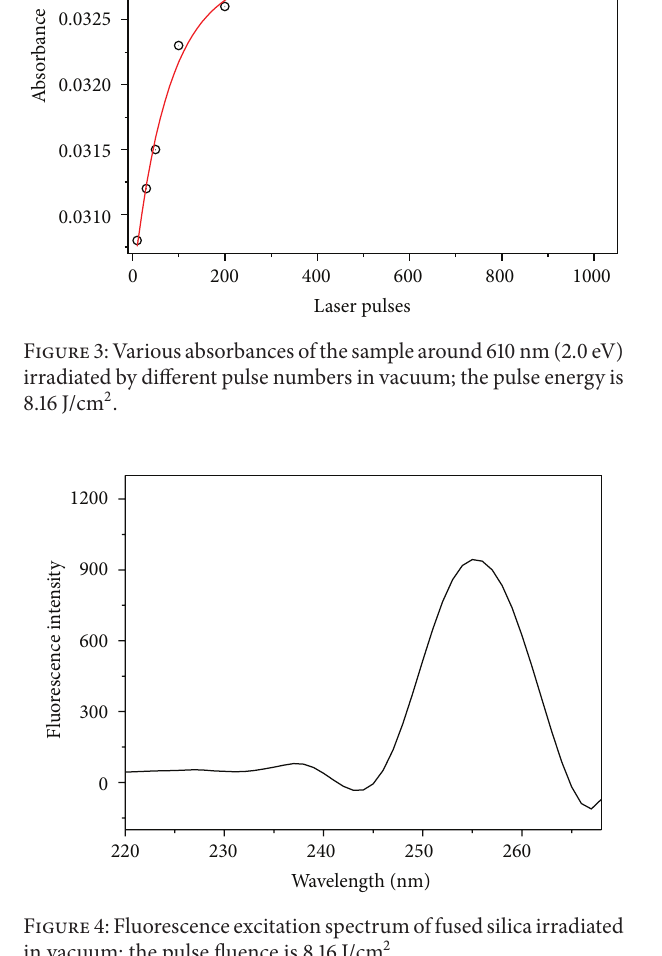
Figure4:Fluorescenceexcitationspectrumoffusedsilicairradiated in vacuum; the pulse fluence is 8.16 J/cm 2 .